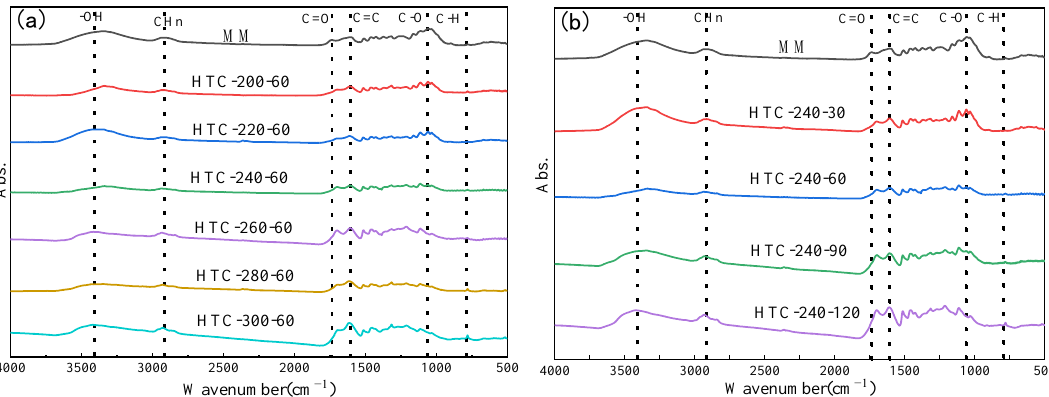
Figure 5. FTIR patterns of different samples, ( a ) different temperatures; ( b ) different holding times.